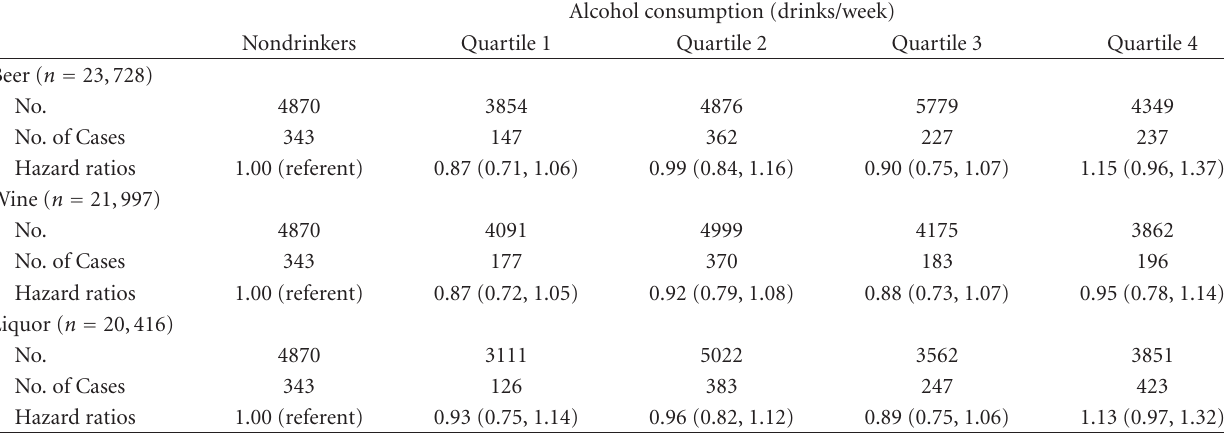
Table 6: Hazard ratios of all-cause mortality stratified by types of alcohol beverage a , Aerobics Center for Longitudinal Study (ACLS), 1974–